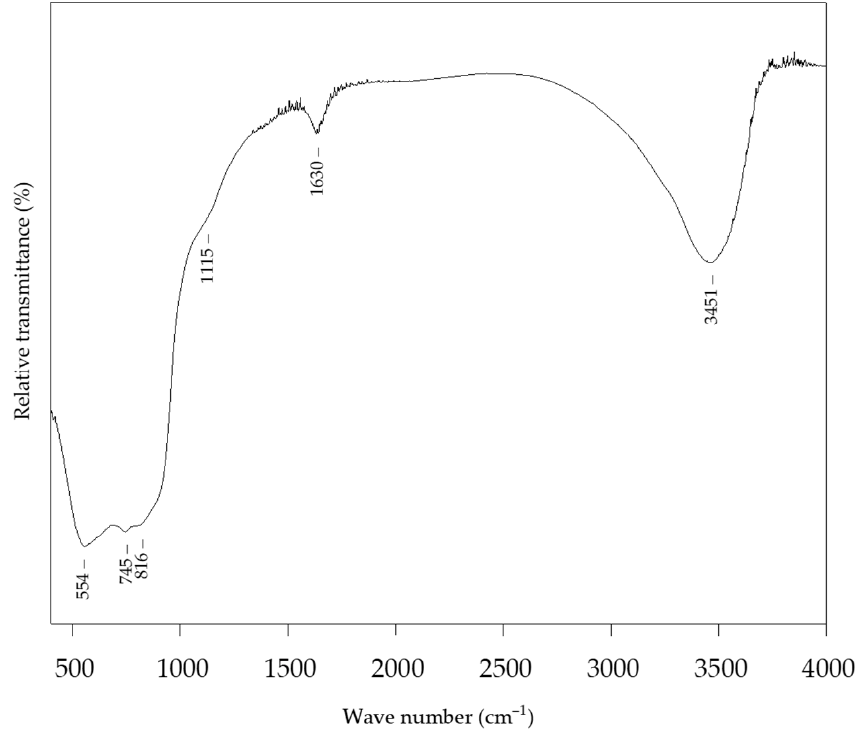
Figure 5. FTIR spectrum of alumina NPs.